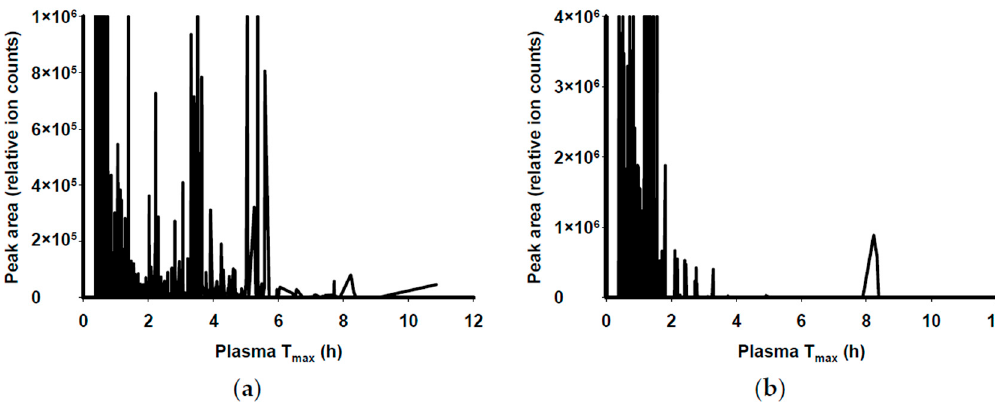
Figure 1. “Functional fingerprints” of plant extracts predicting absorption in humans based on the PCAP model [41] and the LC-MS method [42]. Functional fingerprints of ( a ) red cabbage; and ( b ) grape skin extracts. T max , the time required for phytochemicals to reach their maximal plasma concentration.